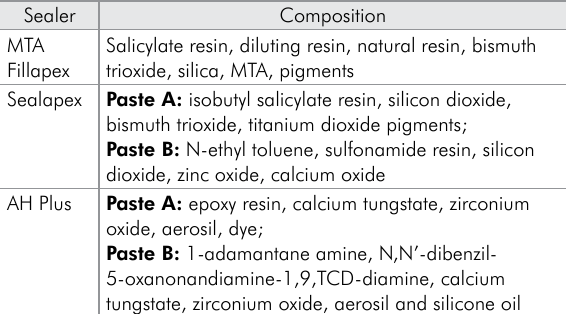
table 1. Composition of the endodontic sealers. Sealer